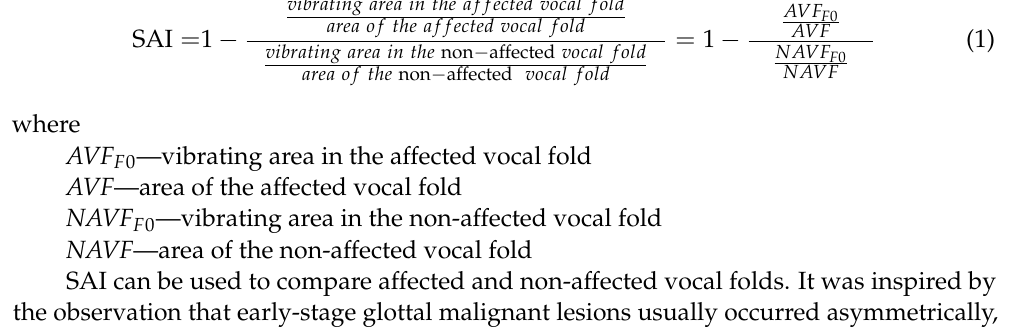
Figure 4. The laryngotopography of the fundamental frequency ( a ) and FFT plot ( b ) for two marked points of the LHSV image, the blue plot corresponds to the area of vibration of the vocal folds and the green plot corresponds to the area in which no regular periodic movement was detected. The color on the map was taken from a color palette (shown on the right-hand side of the image) in which different colors were assigned to different frequency